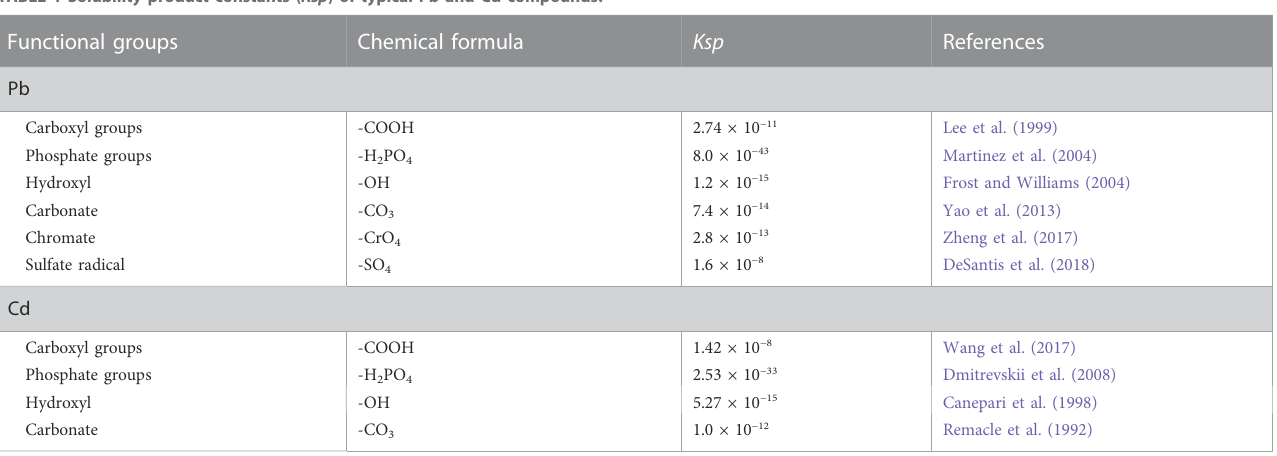
TABLE 1 Solubility product constants ( Ksp ) of typical Pb and Cd